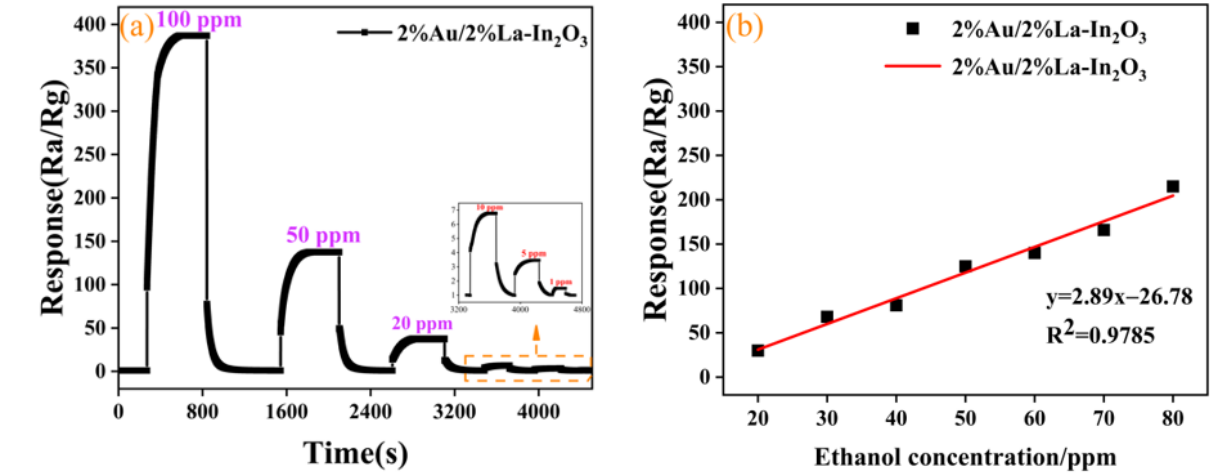
Figure 5. The gas sensing performance: ( a ) The response to different ethanol concentrations. ( b ) The linear fitting relationship between response and ethanol concentration.